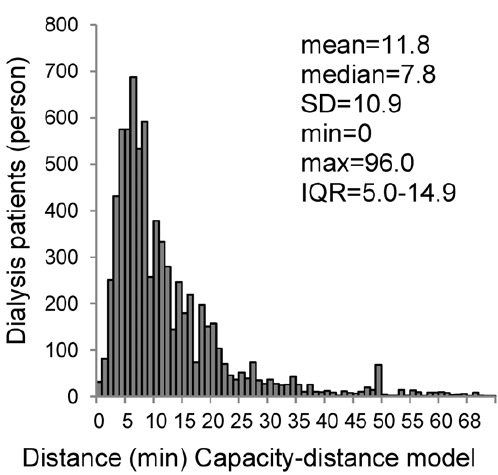
Figure 2. Distribution travel times of dialysis patients in capacity-distance model. IQR, interquartile range; SD, standard deviation.